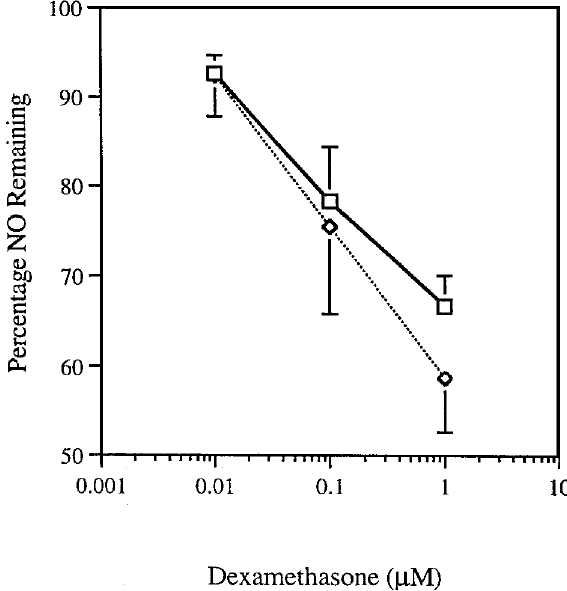
FIG. 4. Effect of Lc-1 immunoneutralization on dexametha- sone-mediated inhibition of NO release by LPS-stimulated rat AM in vitro (10 m g/ml LPS). Data are presented as mean ± SEM, n = 6; open squares represent LPS-stimulated release in the presence of dexamethasone and Lc-1 neutralizing antibody (1:50 dilution); open diamonds represent LPS- stimulated release in the presence of dexamethasone